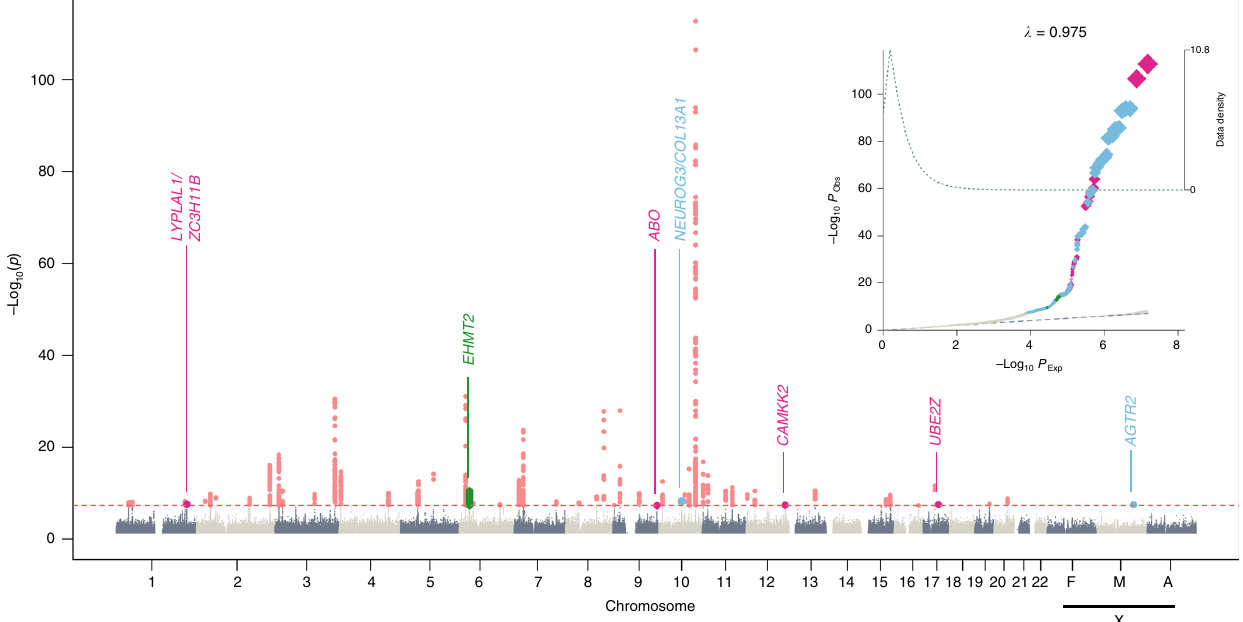
Fig. 2 Manhattan and quantile – quantile plot (QQ-plot) of the discovery and replication genome-wide meta-analysis. The upper corner represents the QQ- plot. Expected − log 10 p -values under the null hypothesis are represented in the x axis, while observed − log 10 p -values are represented in the y axis. Observed p -values were obtained according to the suitable replication dataset used (as shown in Fig. 1) and were depicted using different colors. HapMap variants were meta-analyzed using the trans-ethnic summary statistics from the DIAGRAM study and our meta-analysis based on the Genetic Epidemiology Research on Aging (GERA) cohort and the northwestern NuGENE project, and that resulted in novel associations depicted in magenta. The rest of non-HapMap variants meta-analyzed using the full 70KforT2D cohort are represented in gray, and the fraction of novel GWAS-signi fi cant variants is highlighted in light blue. Coding low-frequency variants meta-analyzed using the 70KforT2D and the T2D Portal data that resulted in novel GWAS- signi fi cant associations are depicted in green. The shaded area of the QQ-plot indicates the 95% con fi dence interval under the null and a density function of the distribution of the p -values was plotted using a dashed line. The λ is a measure of the genomic in fl ation and corresponds to the observed median χ 2 test statistic divided by the median expected χ 2 test statistic under the null hypothesis. The Manhattan plot, representing the − log 10 p -values, was colored as explained in the QQ-plot. All known GWAS-signi fi cant associated variants within known T2D genes are also depicted in red. X chromosome results for females (F), males (M), and all individuals (A) are also